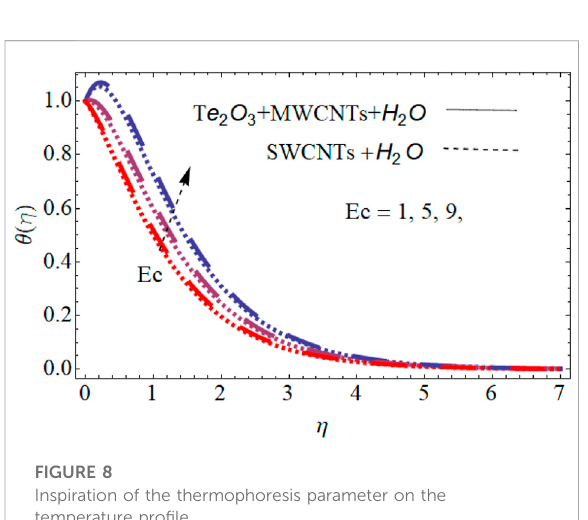
FIGURE 8 Inspiration of the thermophoresis parameter on the temperature pro fi le.